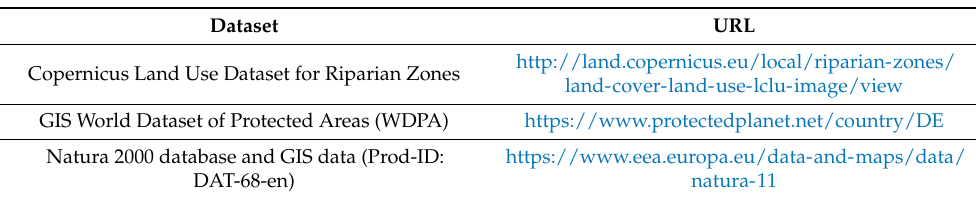
Table 3. Data sources of applied GIS datasets and database for evaluating the naturalness of